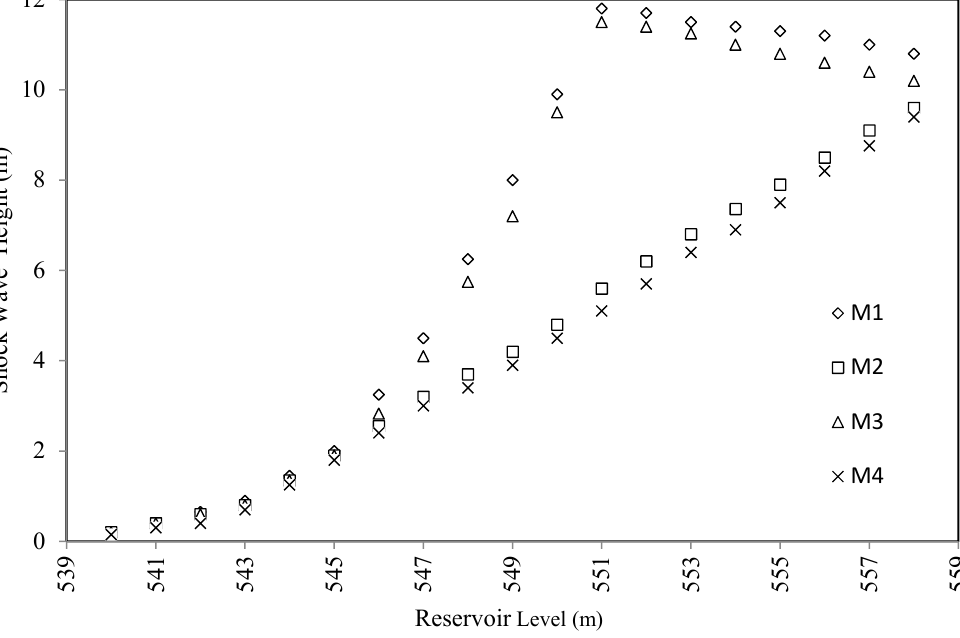
Figure 4. Observed shock wave heights for all geometric variables.